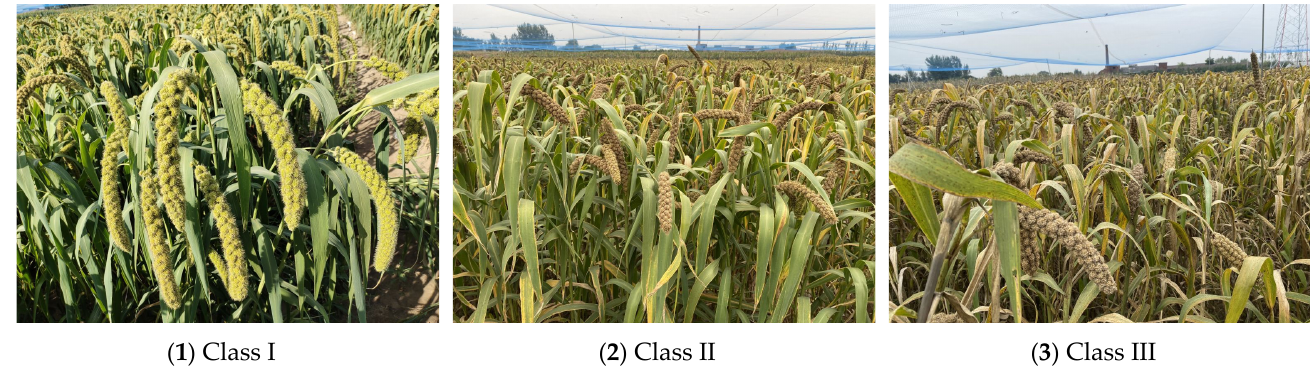
Figure 1. Images of foxtail millet ears at different growth stages.